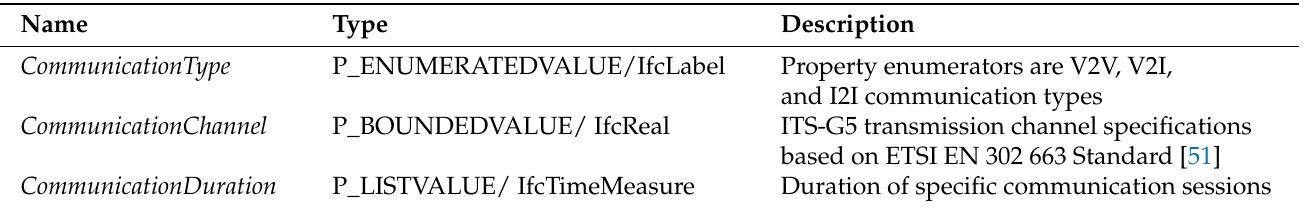
Table 2. Property set Pset_DistributionSystemTypeITSC for describing IfcDistributionSystem entities of type COMMUNICATION .